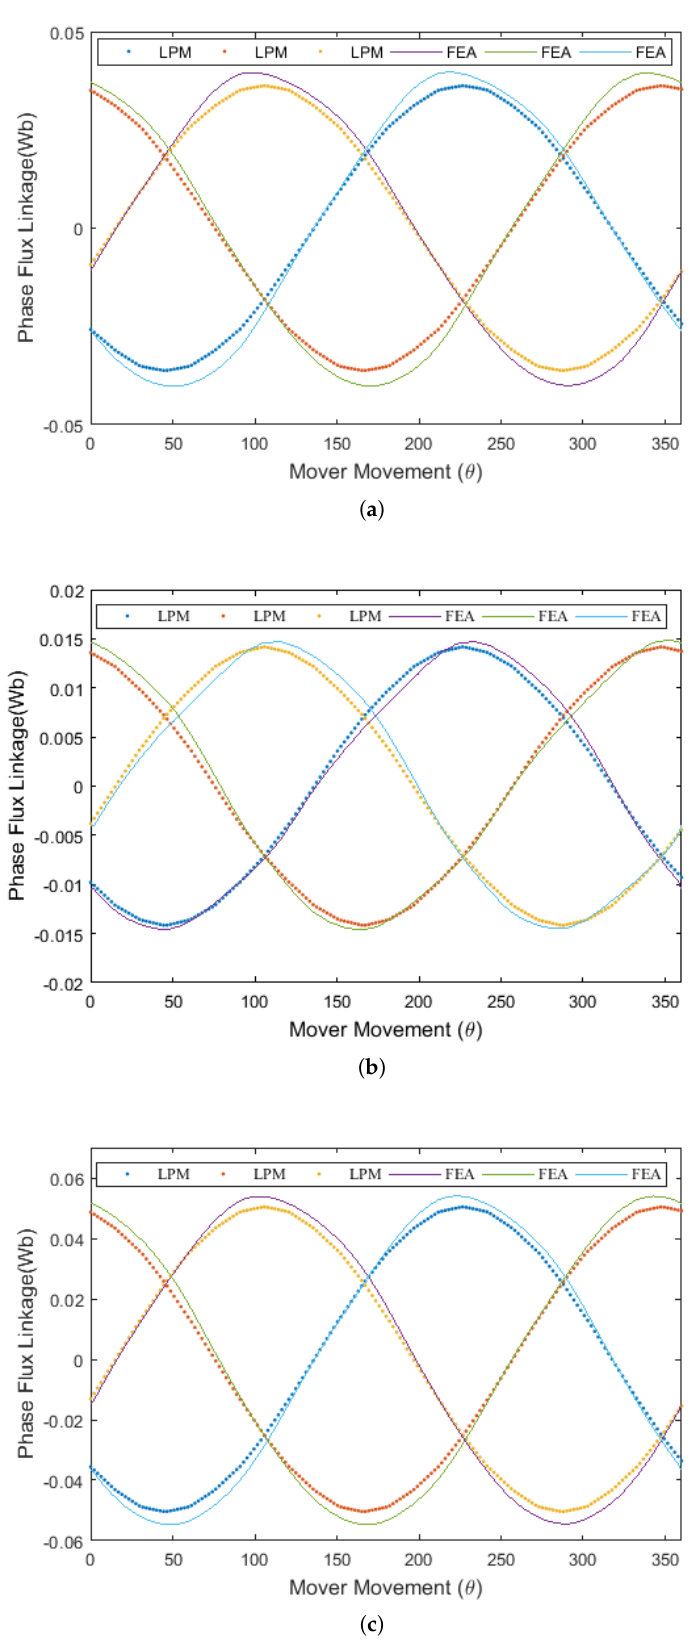
Figure 6. ( a ) PM flux linkage FEA vs. LPM ( b ) FE flux linkage FEA vs. LPM ( c ) PM+FE flux linkage FEA vs.